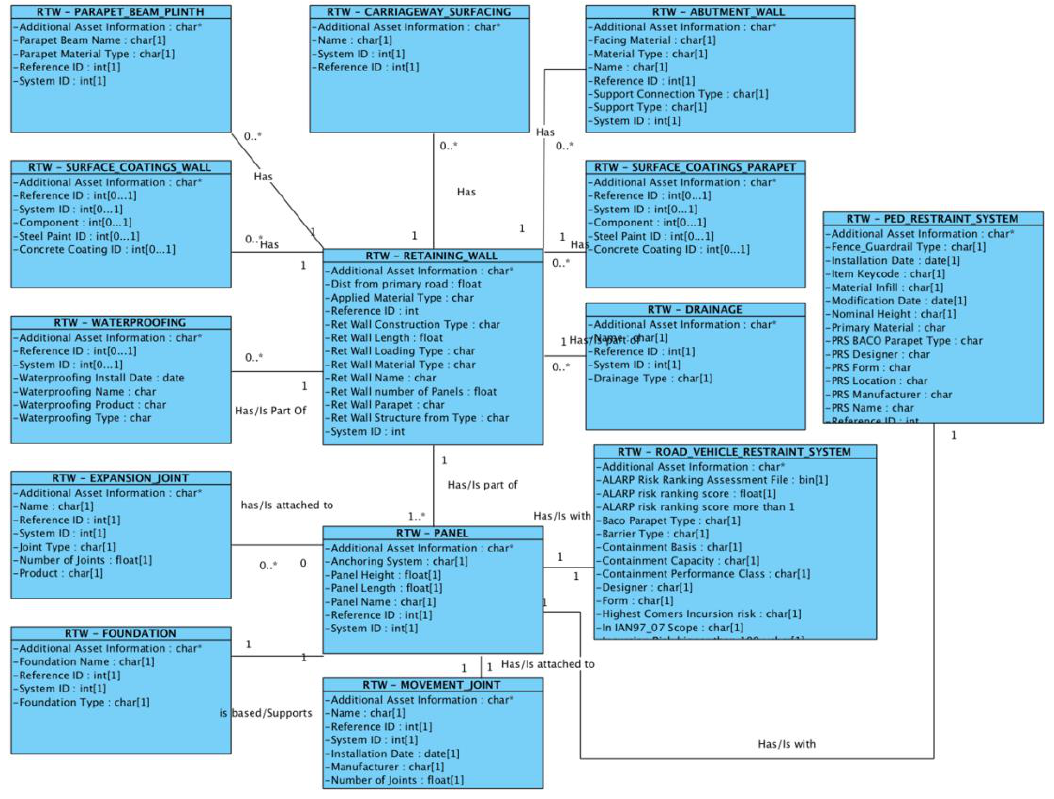
Figure 3: UML Diagram for the Retaining Wall